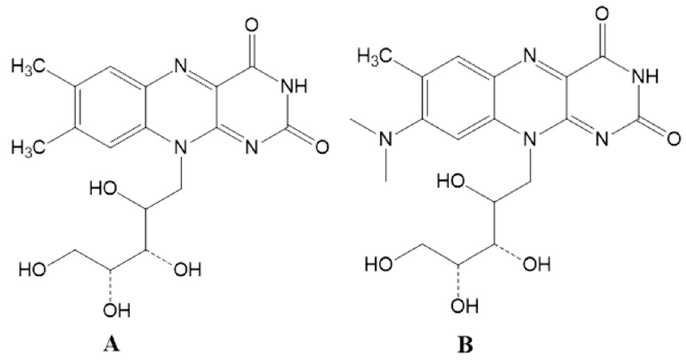
Figure 1. The chemical structures of riboflavin ( A ) and its analog roseoflavin ( B ).